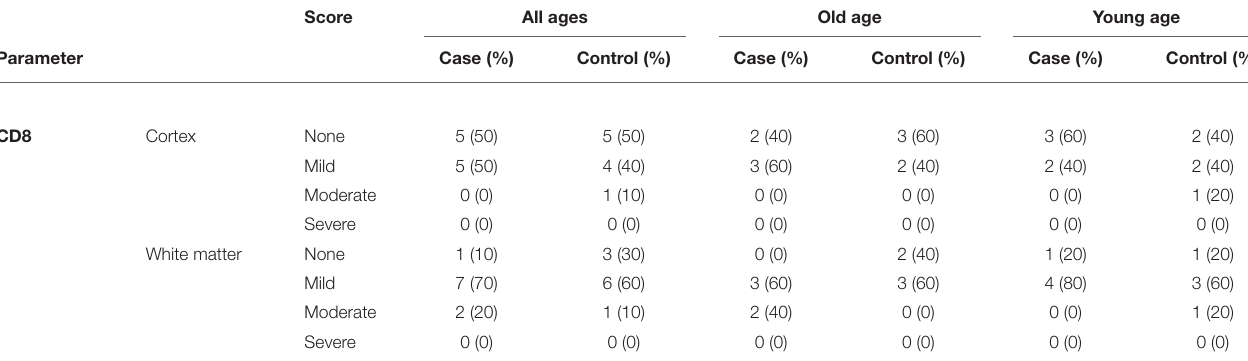
TABLE 4 | Semiquantitative analysis of CD8-positive T-lymphocytes in COVID-19 patients and controls. Score All ages Old